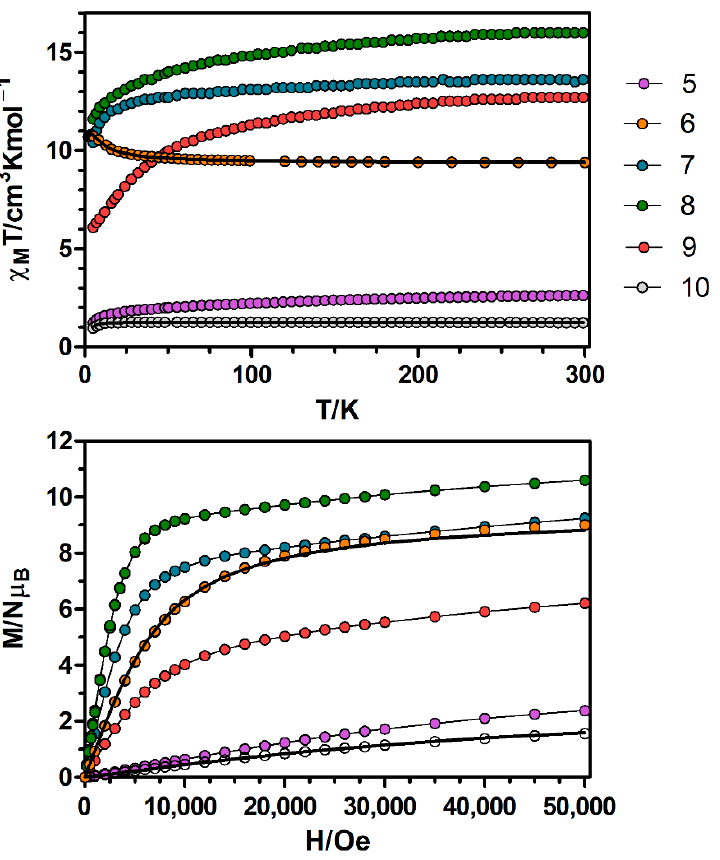
Figure 4. Top: Temperature dependence of the χ M T product at 1000 Oe for complexes 5–10 . Bottom: M versus H plots for complexes 5–10 at 2 K. Black solid lines show the best fits for complexes 6 and 10 . The rest of the lines are a guide to the eye.